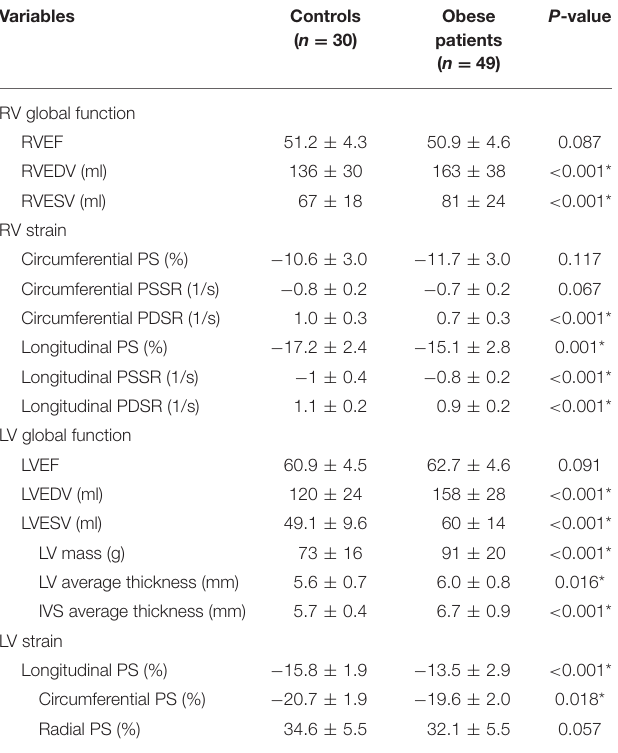
TABLE 3 | Association (correlation coefficients) between cardiac geometry, function, and RV strains in obese patients. RV Circumferential